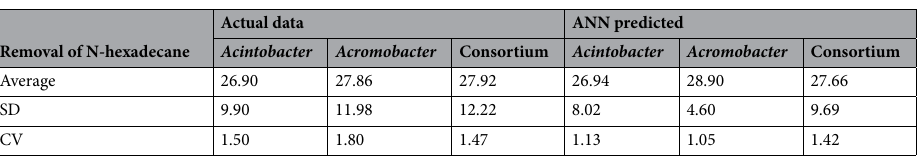
Table 4. Average removal of N-hexadecane by all three cultures in actual data and values predicted by